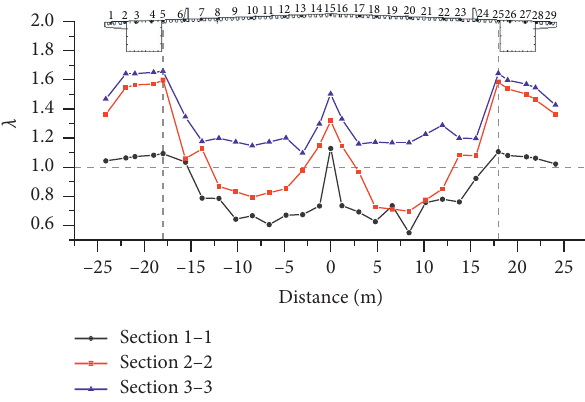
Figure 13: Shear lag coefficient.